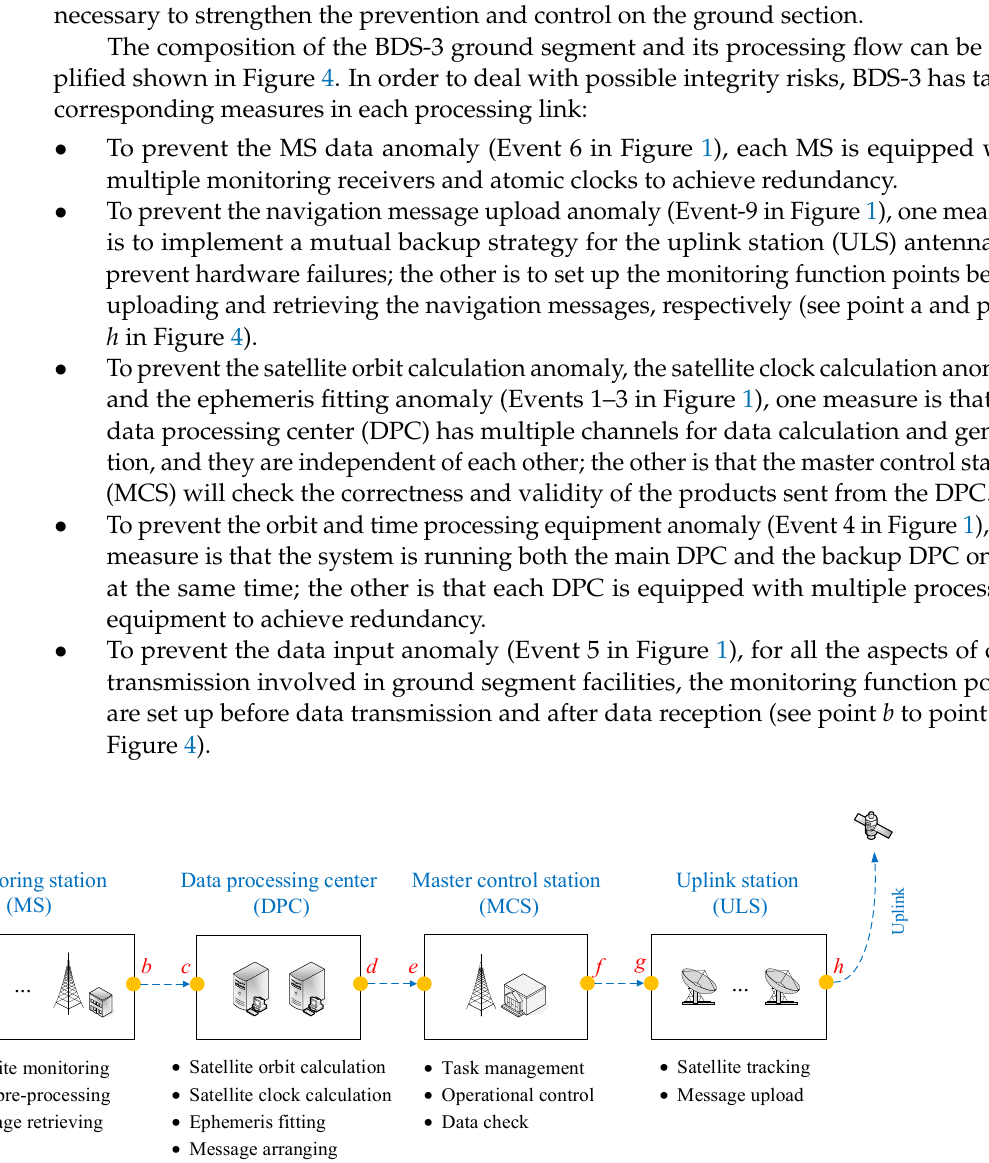
Figure 4. Information processing and fault monitoring of BDS-3 ground section. The yellow points a to h represent the fault monitoring function points in the ground segment.